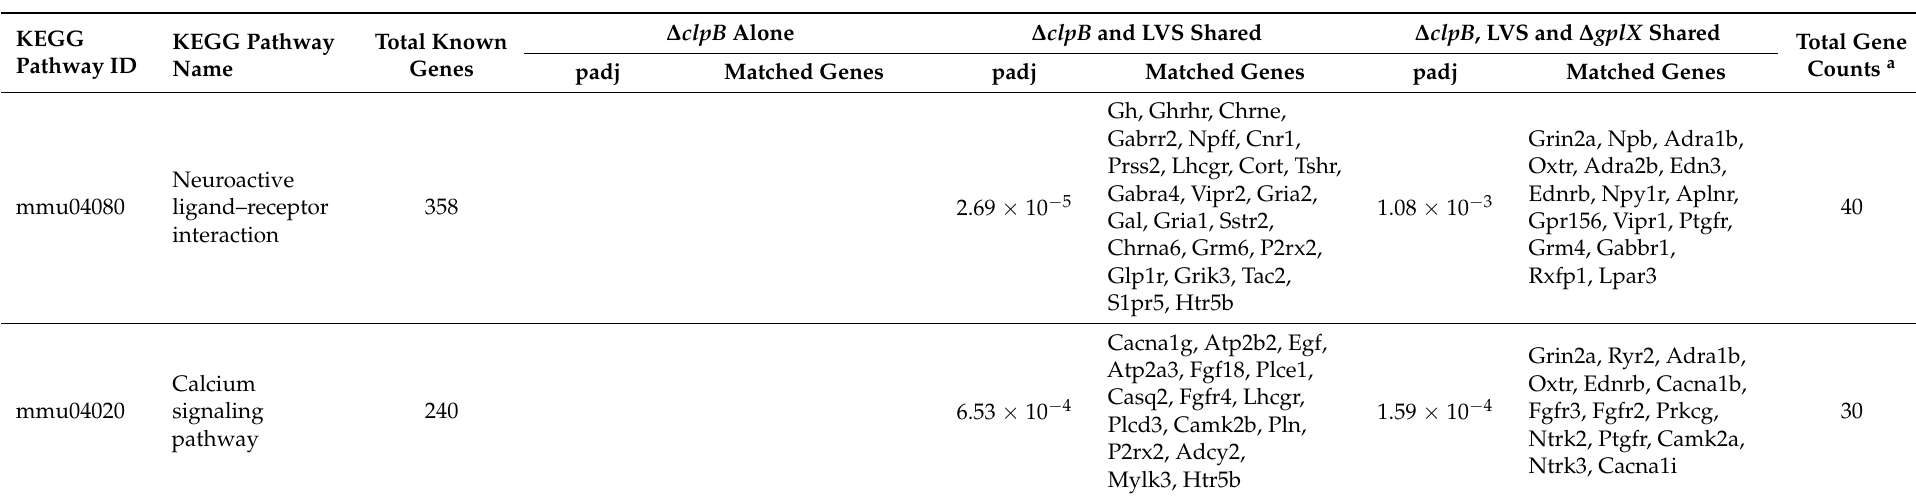
Table 4. Participation of down-regulated genes in KEGG pathways in the three vaccine strains that protect against ID challenge against SCHU S4